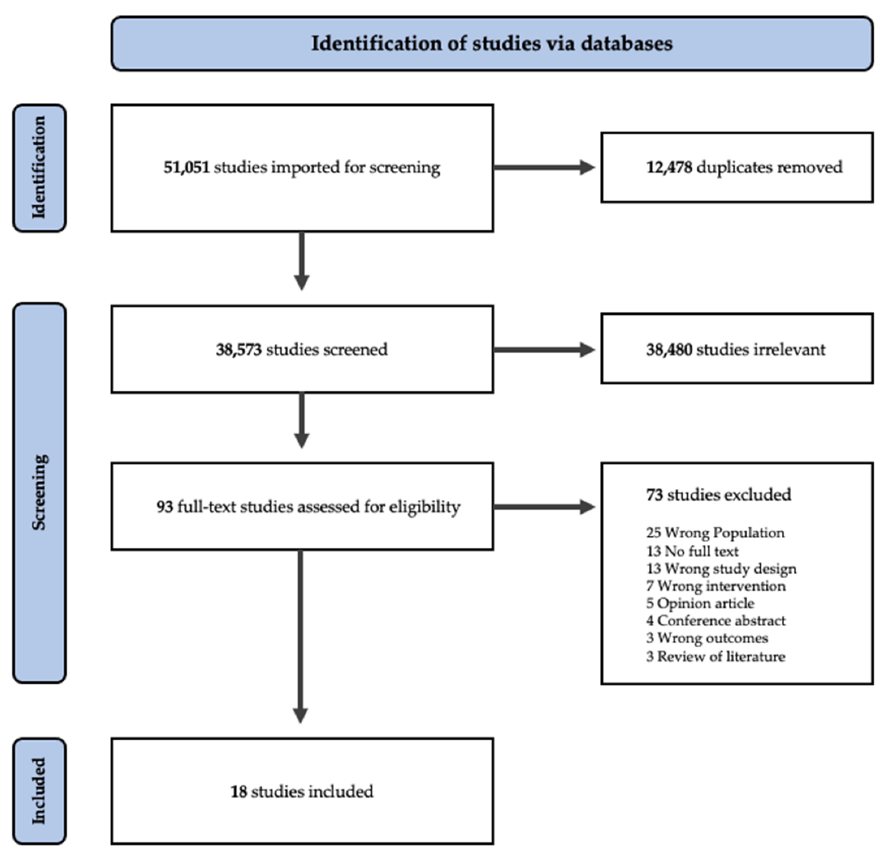
Figure 1. PRISMA fl ow chart outlining the procedure of extracting articles for inclusion. Figure 1. PRISMA flow chart outlining the procedure of extracting articles for inclusion. Table 1. Exposure to aquatic environments as an intervention on infants (included